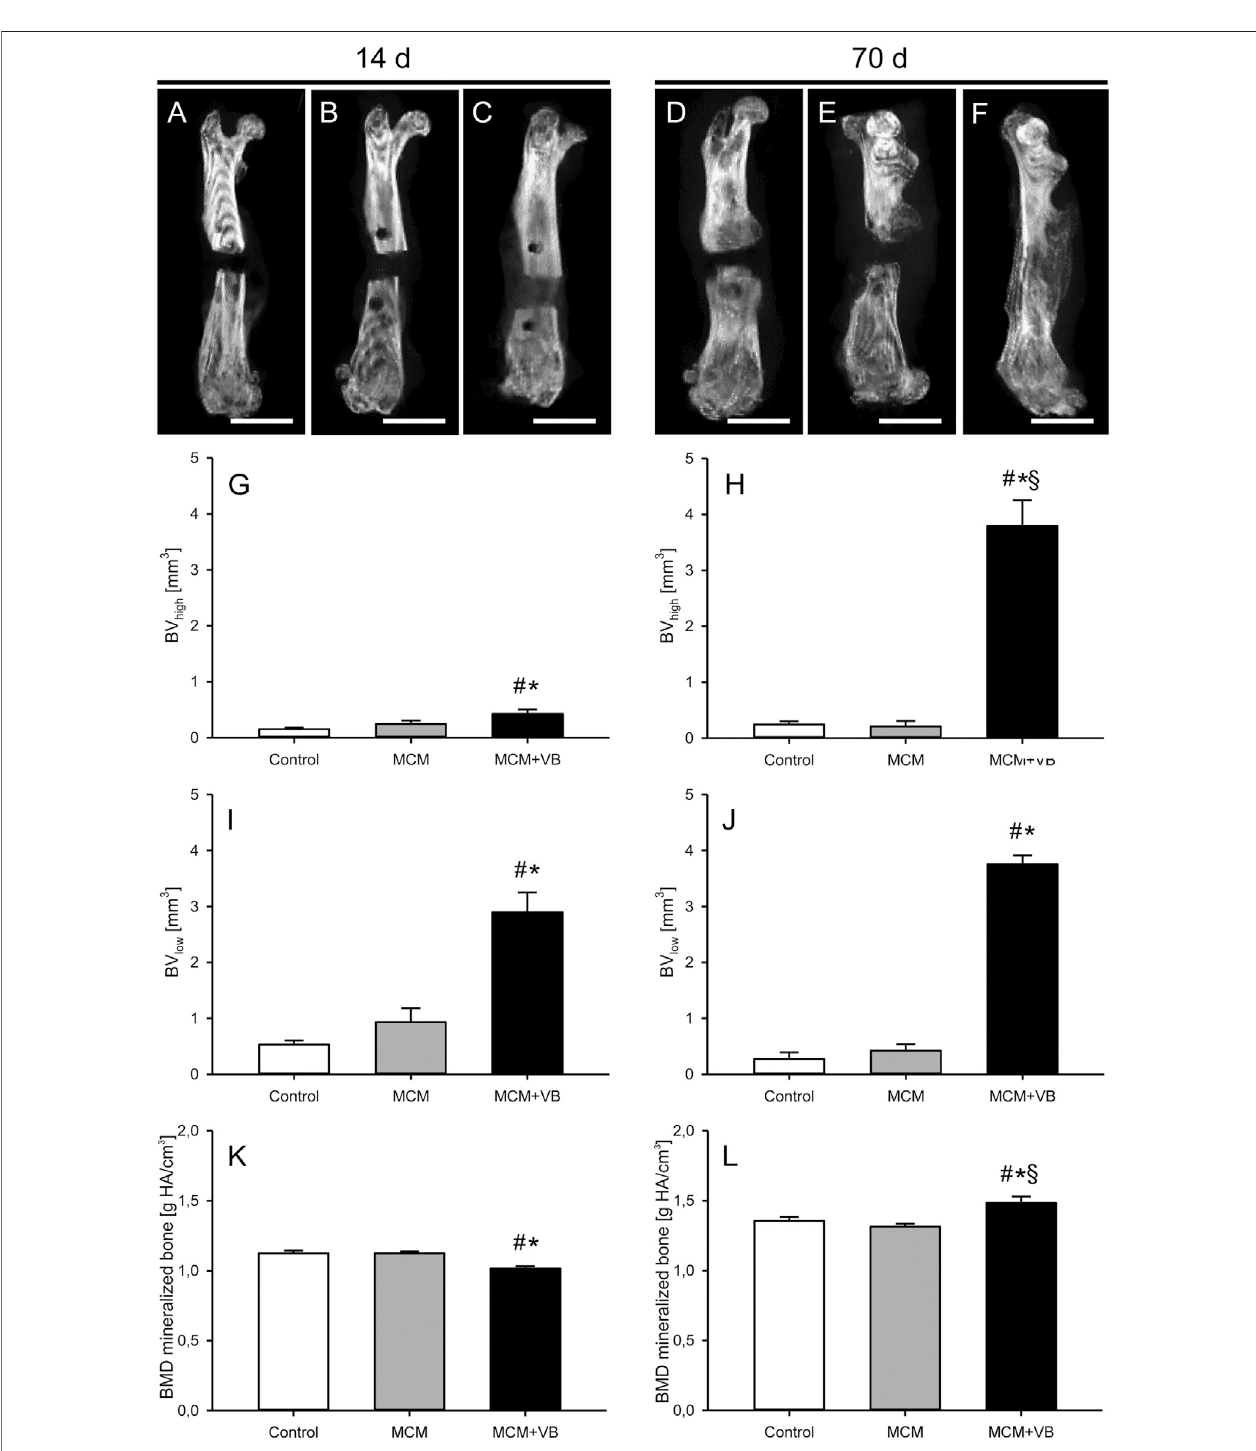
FIGURE4| µCTanalysisofmousefemurs. A-F: µCTimagesoffemurs at14days (A-C) and70 days (D-F) aftersurgeryofcontrol (A,D) ,MCM (B,E) andMCM+ VB (C, F) animals. Scale bars: 2 mm. G, H: Volume of high mineralized bone (BV high ) at 14 days (G) and 70 days (H) after osteotomy within the callus of control (n (cid:1) 8), MCM (n (cid:1) 8) and MCM + VB(n (cid:1) 8) femurs. I, J : Volume oflowmineralized bone (BV low ) at 14 days (I) and 70 days (J) after osteotomy within the callus ofcontrol (n (cid:1) 8), MCM(n (cid:1) 8)andMCM+VB(n (cid:1) 8)femurs. K,L :BMDoftotalmineralizedbonevolumeat14 days (K) and70 days (L) afterosteotomywithinthecallusofcontrol(n (cid:1) 8), MCM (n (cid:1) 8) and MCM + VB (n (cid:1) 8) femurs. Mean ± SEM; # p < 0.05 vs control; * p < 0.05 vs MCM. § p < 0.05 vs MCM + VB at day 14.